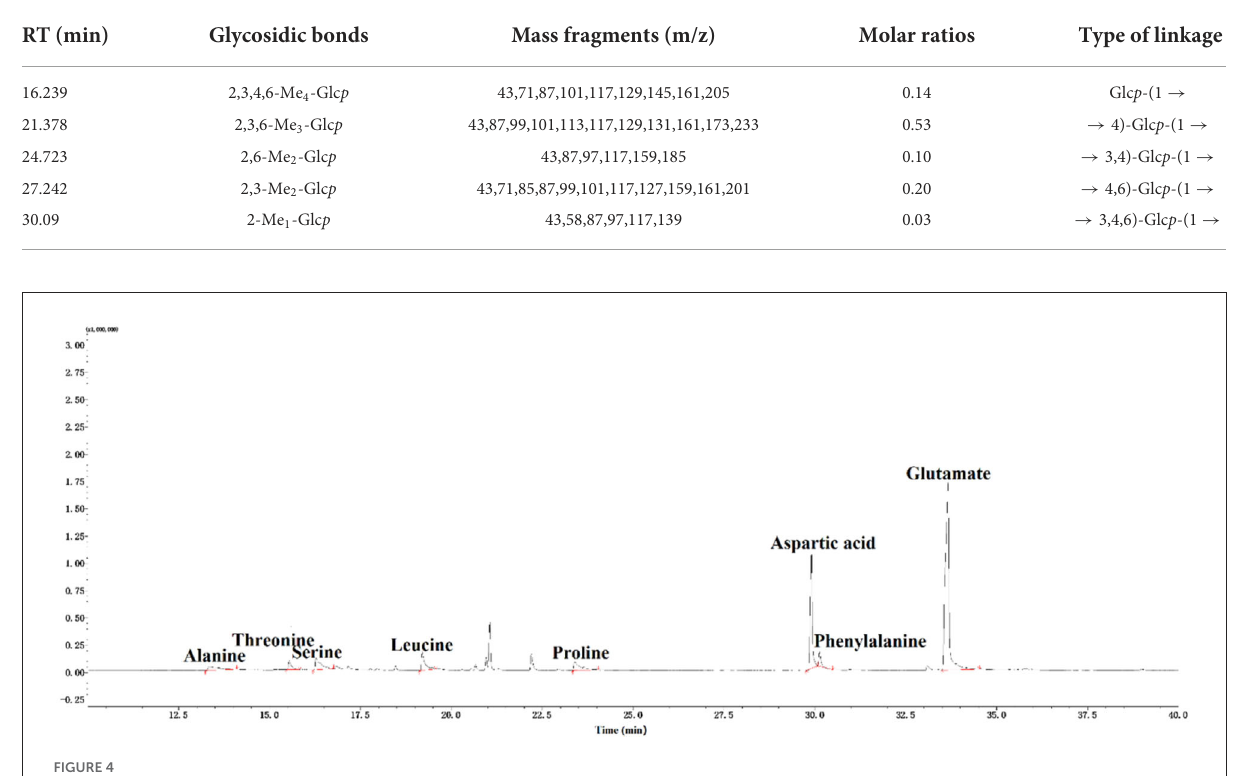
FIGURE4 GC-MS spectra of amino acids in CAG-1.